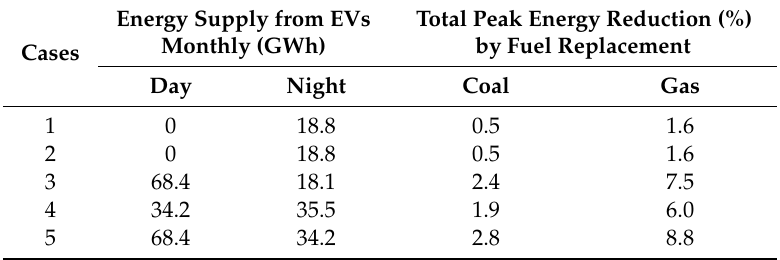
Table 3. Potential fossil fuel reduction on the peak